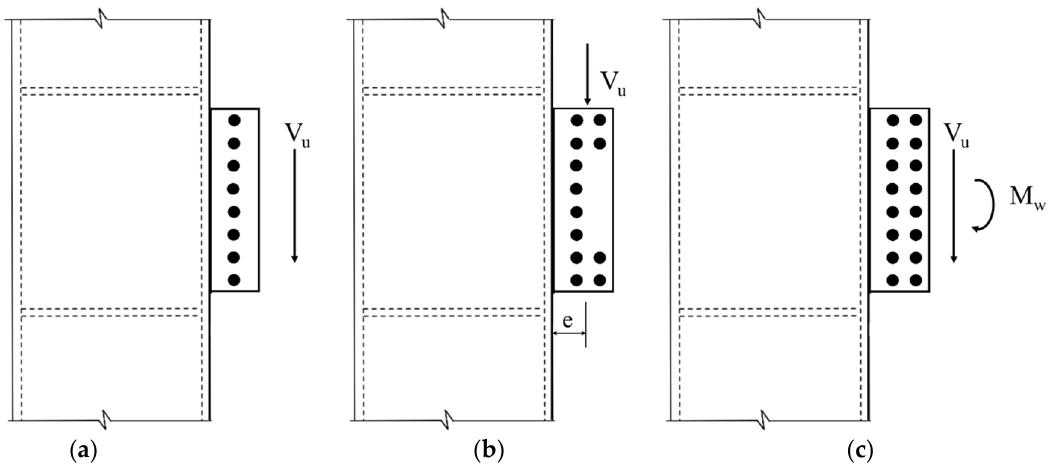
Figure 6. Design consideration of bolted web connections: ( a ) the U.S., ( b ) Taiwan, ( c ) Japan